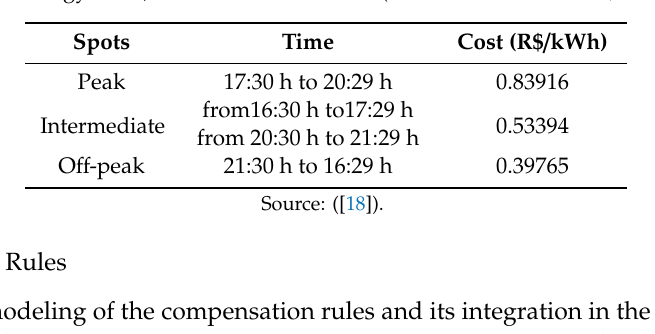
Table 1. Cost of energy in R$ / kWh at the white tari ff (R$ is the Brazilian real, o ffi cial